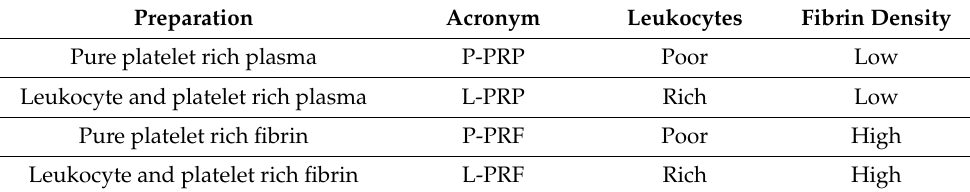
Table 1. Dohan- Ehrenfest PRP classification. Preparation Acronym Leukocytes Fibrin Density Pure platelet rich plasma P-PRP Poor Low Leukocyte and platelet rich plasma L-PRP Rich Low Pure platelet rich fibrin P-PRF Poor High Leukocyte and platelet rich fibrin L-PRF Rich High